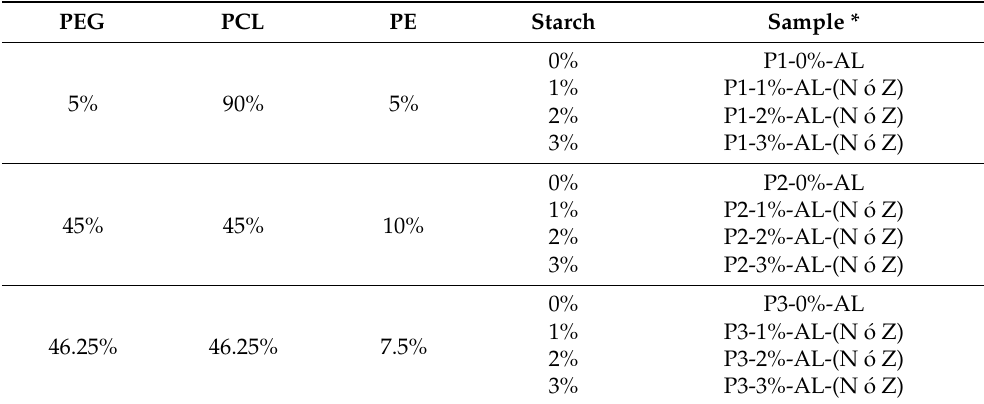
Table 1. Composition of polyurethane